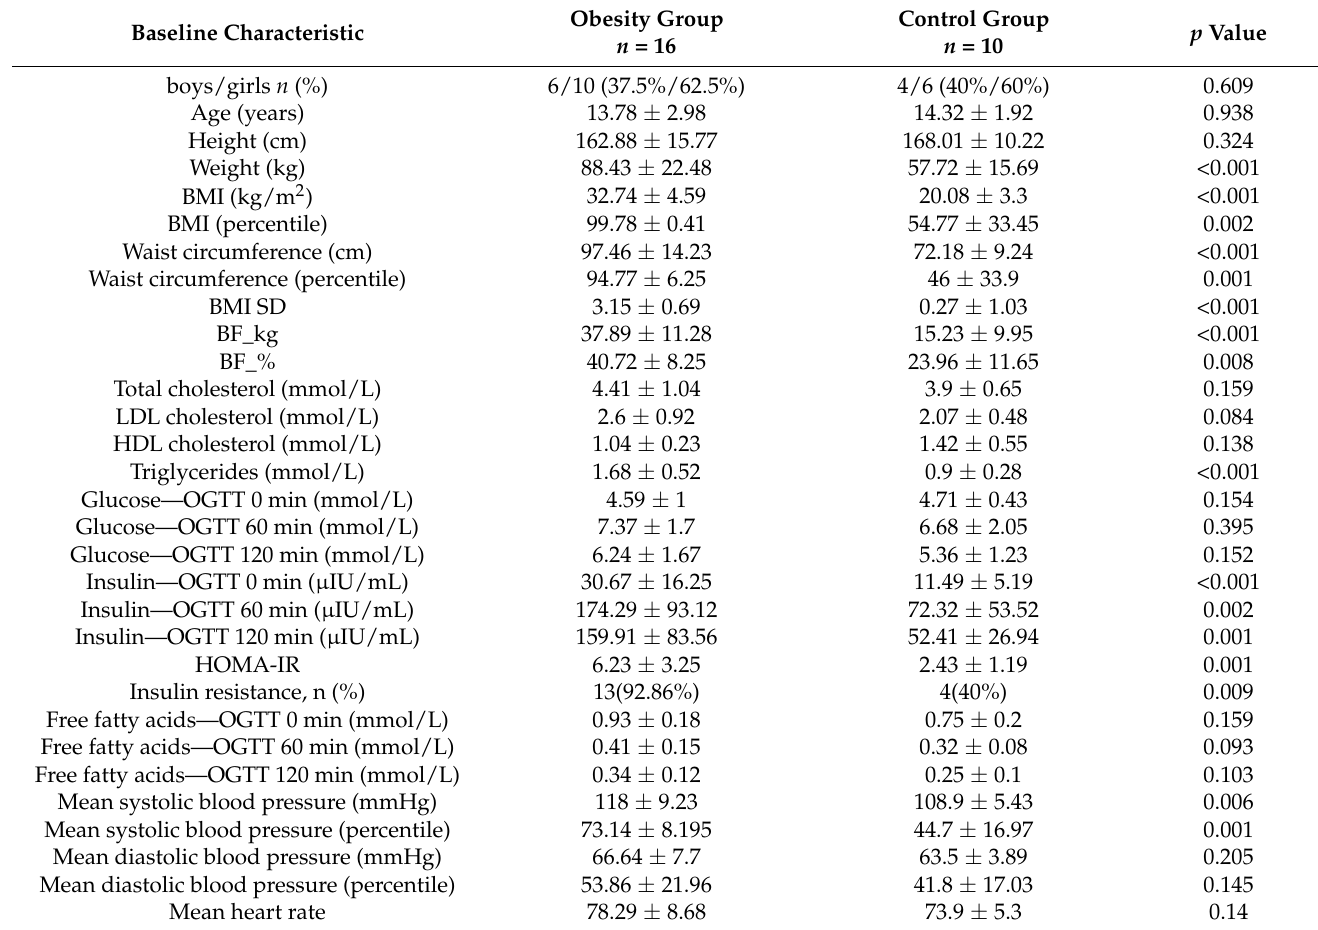
Table 2. Characteristics of the study group.